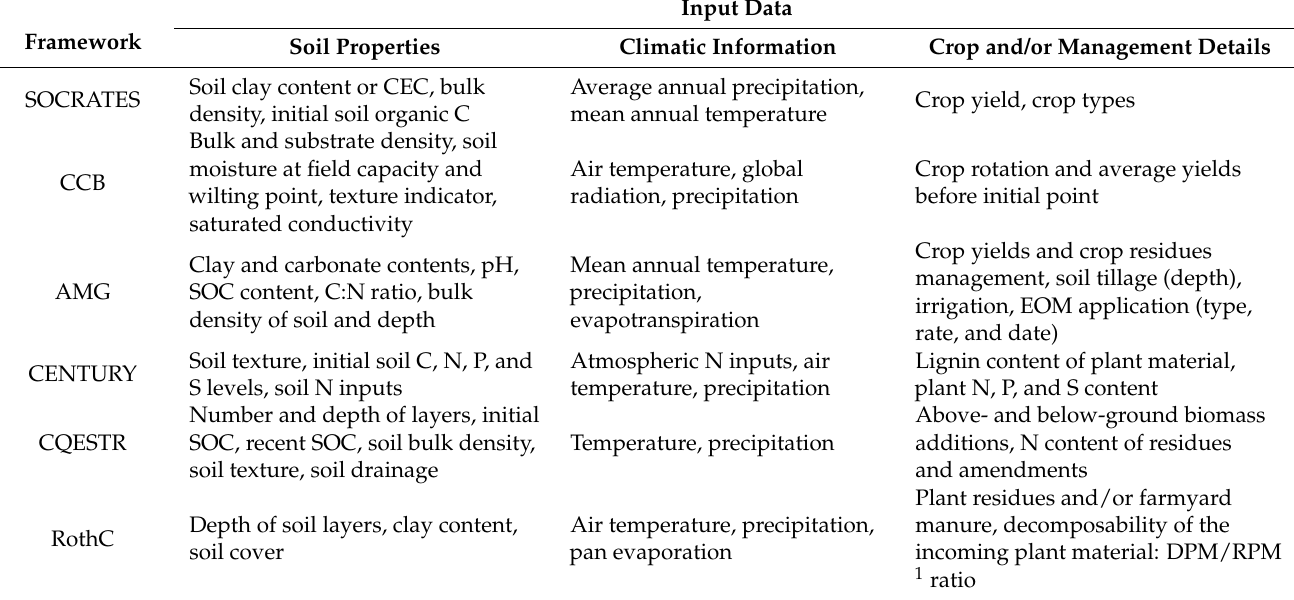
Table 1. Input data required for all 6 frameworks, categorized by soil properties, climatic information, and details of crops and/or crop